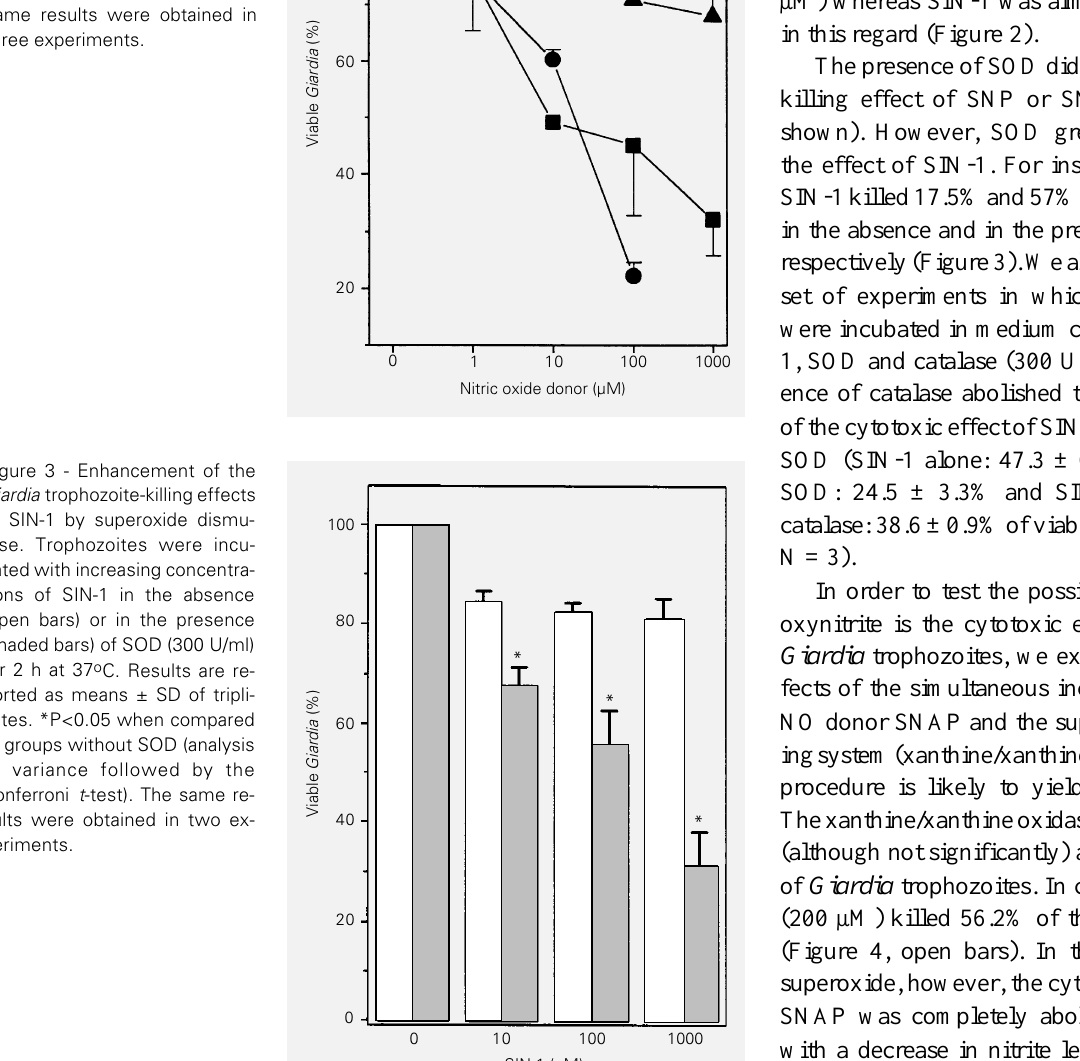
Figure 2 - Effects of increasing concentrations of NO donors on Giardia trophozoite killing. Giar- dia killing was measured by incu- bating trophozoites with SNP ( C ), SNAP ( “ ) or SIN-1 ( £ ) at the indicated concentrations for 2 h at 37 o C. Results are reported as means – SD of triplicates. The same results were obtained in three experiments.